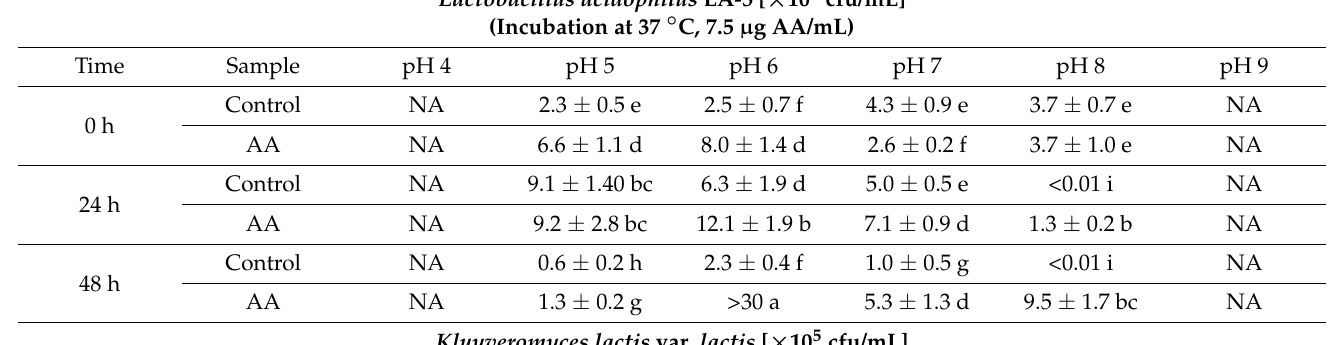
Table 2. The impact of pH on the growth of Kluyveromyces lactis var. lactis and Lactobacillus acidophilus LA-5 in the presence of acrylamide (AA) (n = 5).